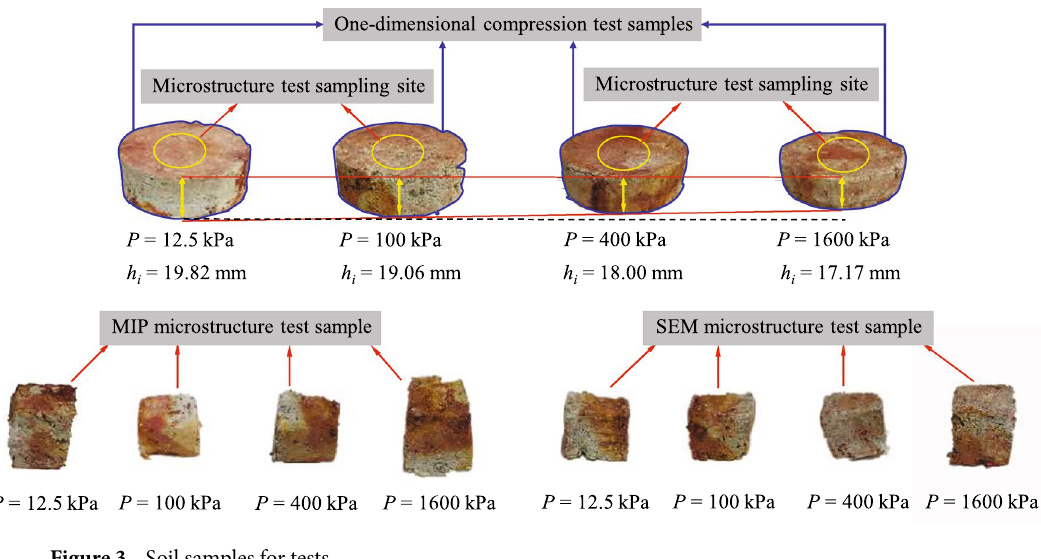
Figure 3. Soil samples for